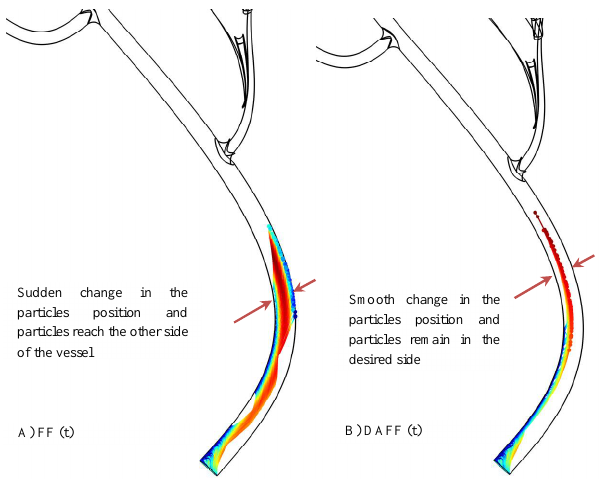
Figure 9. Particle tracking simulation of T s = 7 s for ( A ) a field function ( FF ( t ) ), and ( B ) a discontinuous asymmetrical field function ( DAFF ( t )